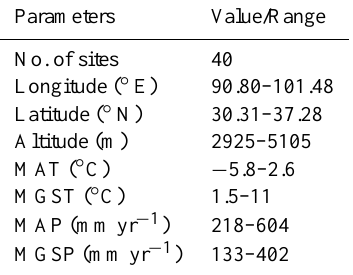
Table 1. Description of the study region. Mean annual tempera- ture (MAT), mean annual precipitation (MAP), mean growing sea- son temperature (MGST) and mean growing season precipitation (MGSP) of the sampling sites are